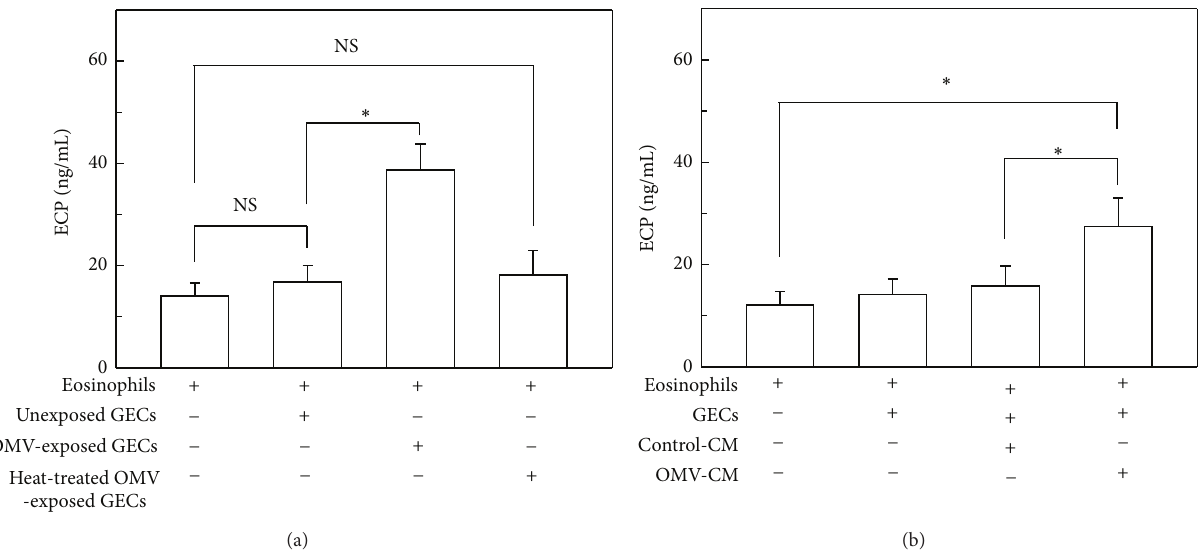
Figure 3: Effects of H. pylori OMV-exposed gastric epithelial cells on ECP released from eosinophils. (a) Primary human gastric epithelial cells (GECs) were exposed to either OMVs (200 𝜇 g/mL) or heat-treated OMVs (200 𝜇 g/mL) for 24 h and then washed twice in PBS. Human eosinophils were cocultured with either OMV-exposed or -unexposed GECs for 24 h. The concentrations of ECP in the culture supernatants were measured by ELISA (mean ± SEM, 𝑛 = 5 ). ∗ 𝑃 < 0.05 ; NS, statistically nonsignificant. (b) Primary human GECs were cultured for 24 h in either the presence or absence of OMVs (200 𝜇 g/mL). Culture supernatants were then collected as described in Materials and Methods. GECs were stimulated with control-CM (50% v/v) or OMV-CM (50% v/v) for 24 h and then washed twice in PBS. Finally, control-CM-exposed or OMV-CM-exposed GECs were cocultured with human eosinophils for 24h. The concentrations of ECP in the culture supernatants were measured by ELISA (mean ± SEM, 𝑛 = 5 ). ∗ 𝑃 < 0.05